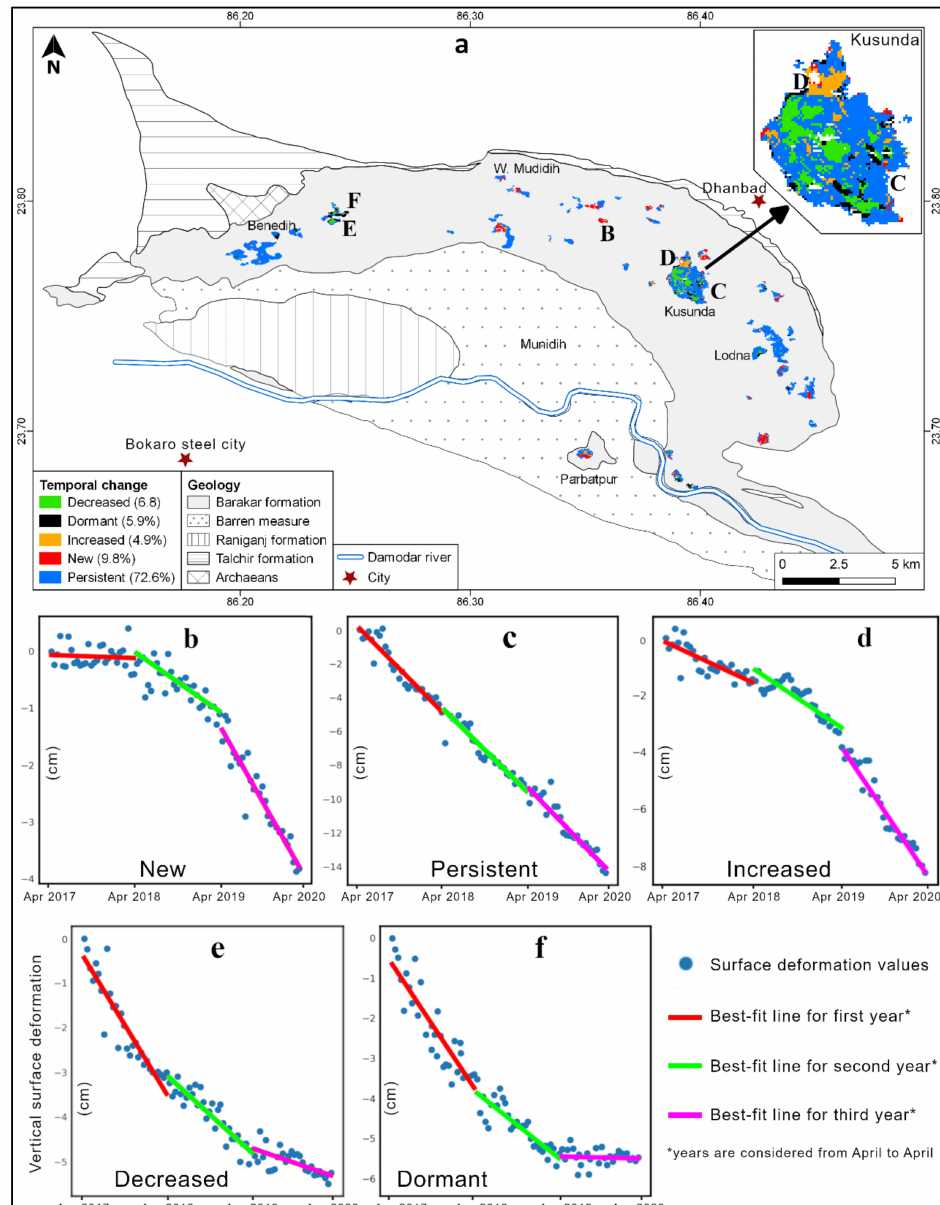
Figure 5. ( a ) Map showing the temporal changes in coal fires in JCF. The percentage of area covered by each category of temporal change is also mentioned in the map legend. The geology map of JCF is used as the basemap. ( b – f ) Graphs representing the time-series of subsidence at corresponding locations marked on the map ( b – f ). Blue points are the original subsidence values, and the best-fit lines for yearly surface deformation are shown in various